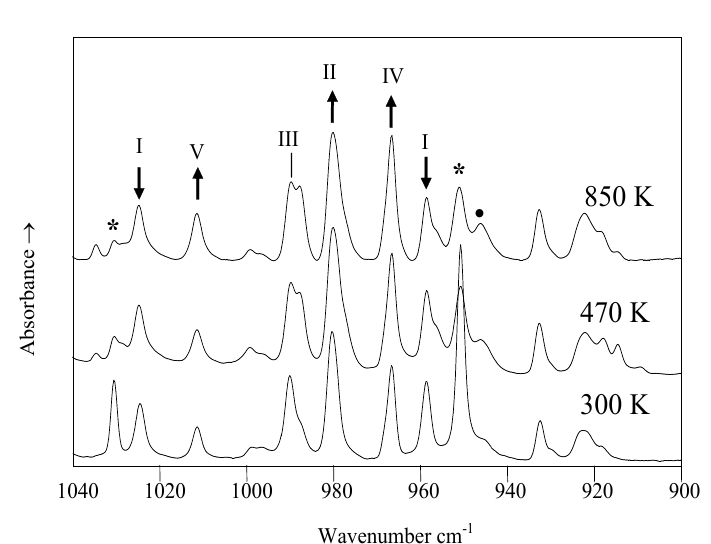
Fig. 6. IR absorption spectra of 1-butene SOZ isolated in N 2 matrix using hot nozzle technique. The nozzle was heated to 300, 470 and 850 K. Arrow denotes temperature evolution of “pure” spectral bands, belonging to various conformers. Asterisk (*) denotes spectral bands of ethene SOZ, (•) denotes spectral band of formic acid.